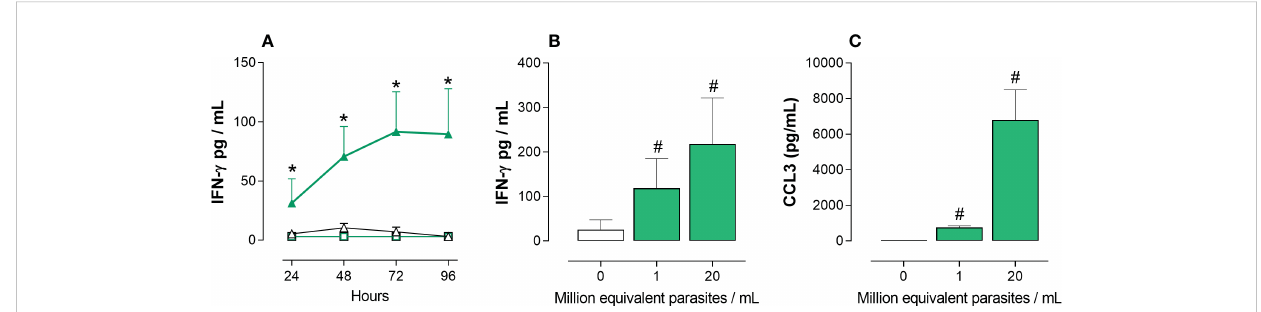
FIGURE 2 IFN- g and CCL3 release by whole cord blood cells in response to a T. cruzi trypomastigotes lysate. Ten-fold diluted whole cord blood from healthy newborns were cultured with (green symbols) or without (white symbols) T. cruzi trypomastigote lysate. IFN- g and CCL3 were measured in the supernatants by ELISA. Results are expressed as mean ± SEM. (A) Cultures (n=4) were performed for 24 to 96h in the absence (square symbols) or the presence (triangle symbols) of IL-2 (5U/mL) and IL-18 (10ng/mL). Parasite lysate was at 10 6 equivalent parasites/mL. *P < 0.05 vs. unstimulated cells cultures in the presence of IL-2 and IL-18 (Two-way Anova). (B) Cultures (n=5) were performed for 72h in the presence of IL-2 (5U/mL) and IL- 18 (10ng/mL), with two parasite lysate concentrations. # P<0.05 vs. the absence of parasite lysate (Wilcoxon test). (C) Cultures (n=5) were performed for 24h with two parasite lysate concentrations. # P<0.05 vs. the absence of parasite lysate (Wilcoxon